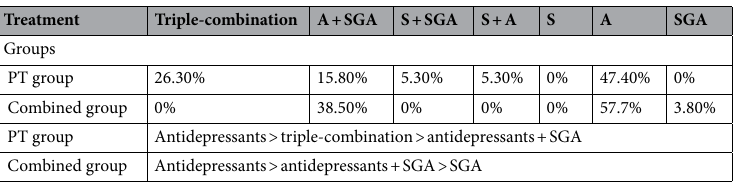
Table 3. The treatment options of psychotropics in different groups. A: antidepressants. S: mood stabilizers. SGA: atypical antipsychotics. Triple-combination: antidepressants + mood stabilizers + atypical antipsychotics. PT group: psychotropics treatment group. Combined group: combined treatment group.